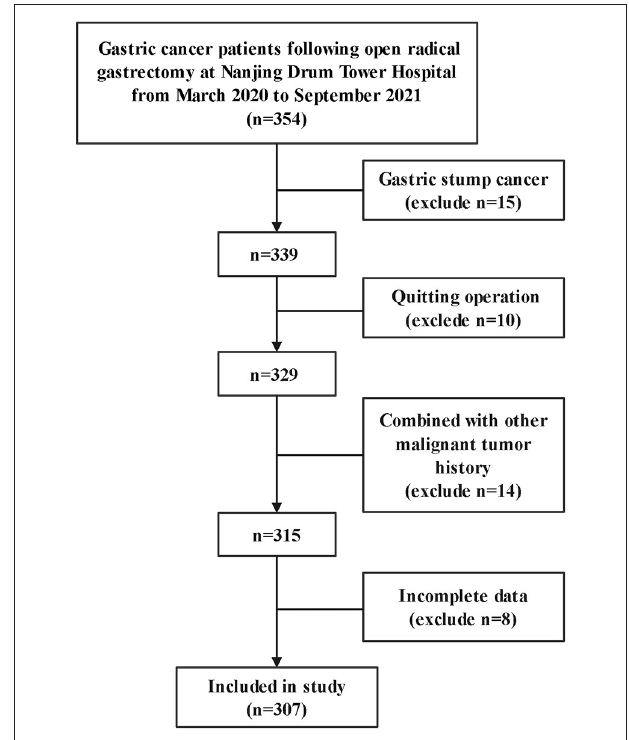
FIGURE 1 | Research flowchart. A total of 307 patients were included in this